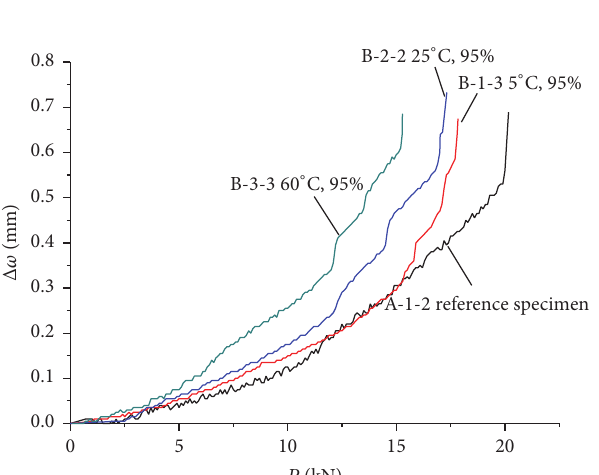
150 mm at each side of the gap. The strain of the CFL was at maximum at the gap location and reduced at the locations away from the gap. The strains also increased with external loading. It needs to be noted that the strain distribution across the width of the CFL was not uniform due to the imperfection in loading and/or